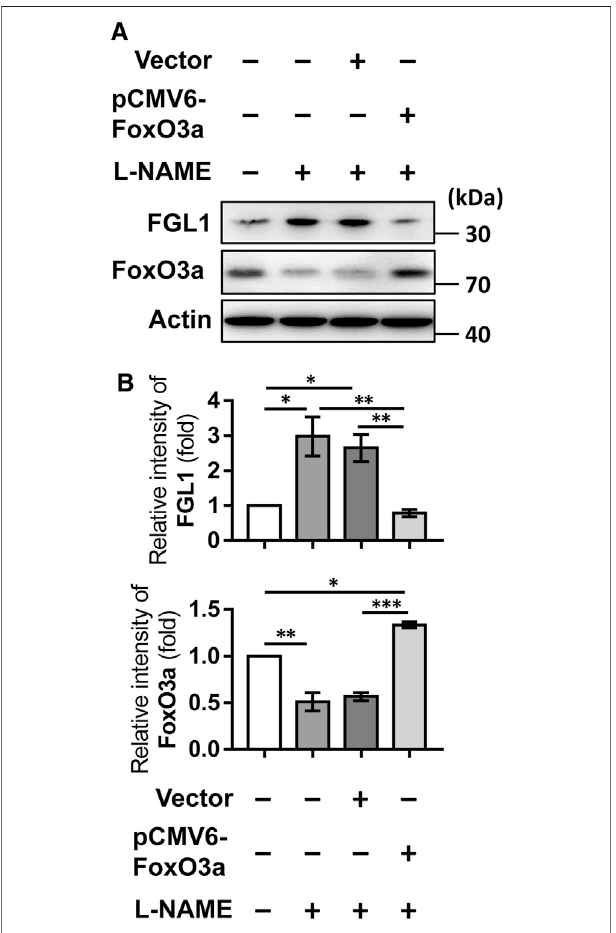
FIGURE 5 | Overexpression of FoxO3a inhibits L-NAME-induced FGL1. (A) After transfection for 48 h and L-NAME (100 μ M) treatment for 24 h, the effects of FoxO3a overexpression on L-NAME-upregulated FGL1 expression were evaluated by Western blotting. (B) Quanti fi ed protein expression levelsofFGL1 and FoxO3a inHTR-8/SVneocells. * p < 0.05; ** p < 0.01; *** p < 0.001 (Tukey ’ s test).